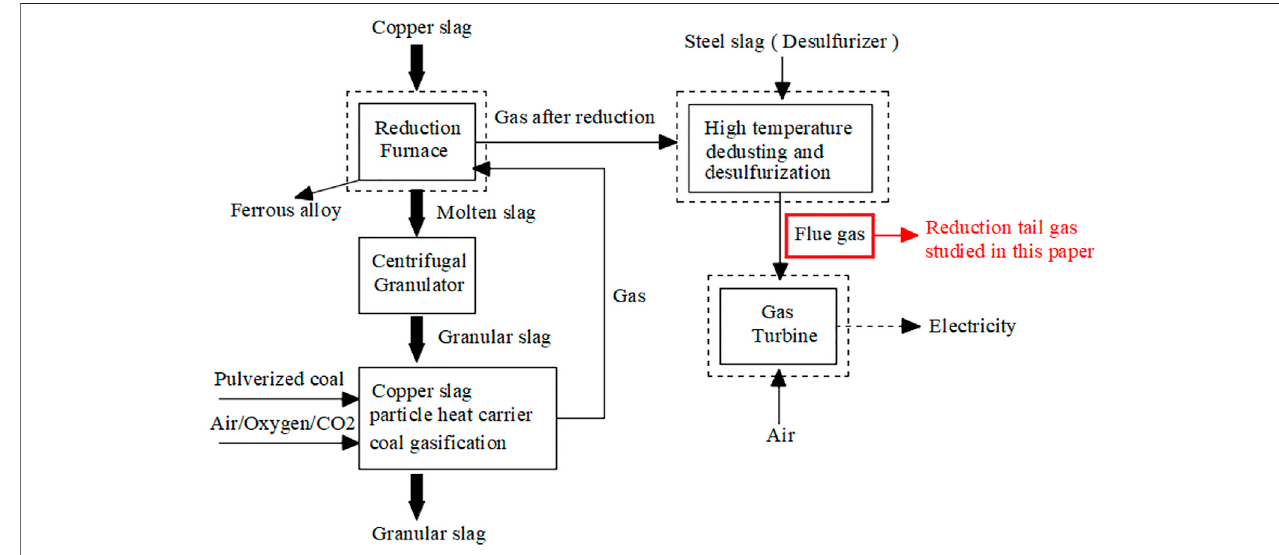
FIGURE 1 | Process fl ow for the preparation of reducing tail gas from copper